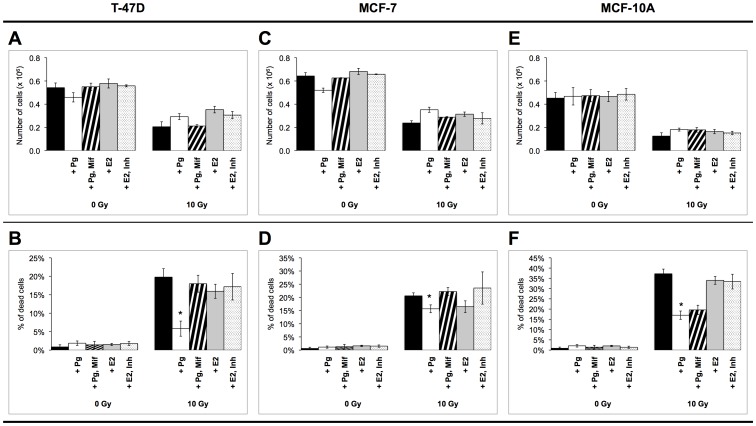
Proliferation and viability of MCF7, T47D and MCF10A cells after irradiation and steroid hormone treatment.Proliferation of T47D (A), MCF7 (C) and MCF10A (E) cells and the number of dead T47D cells (B), MCF7 (D) and MCF10A (F) cells were measured three days after irradiation. Cells were seeded at a density of 105 cells/mL three days before irradiation. Hormonal treatment was performed two days before irradiation and every day afterwards. Pg: progesterone, Mif: mifespristone, E2: estrogen, Inh: PD173074. Results are representative of at least three independent experiments. Error bars represent standard deviation. Asterisks denote significant differences (t-test, *p<0.05, **p<0.01).